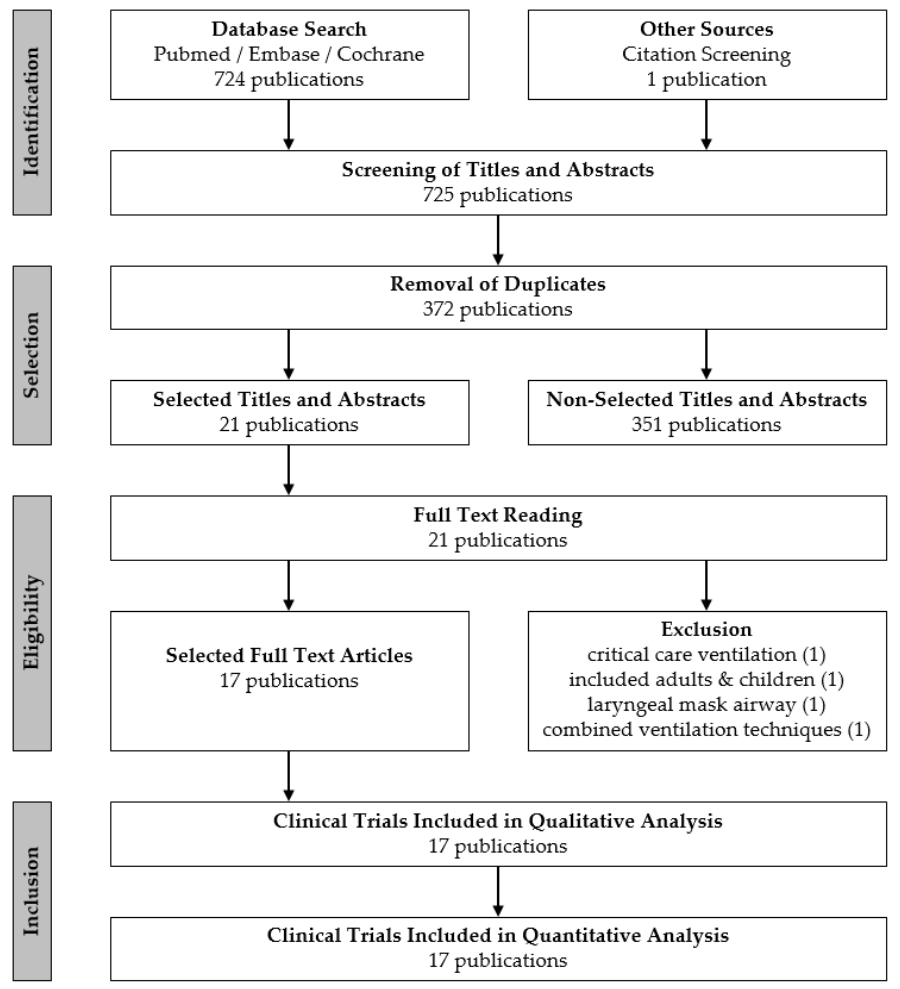
Figure 1. Flow chart of study selection.